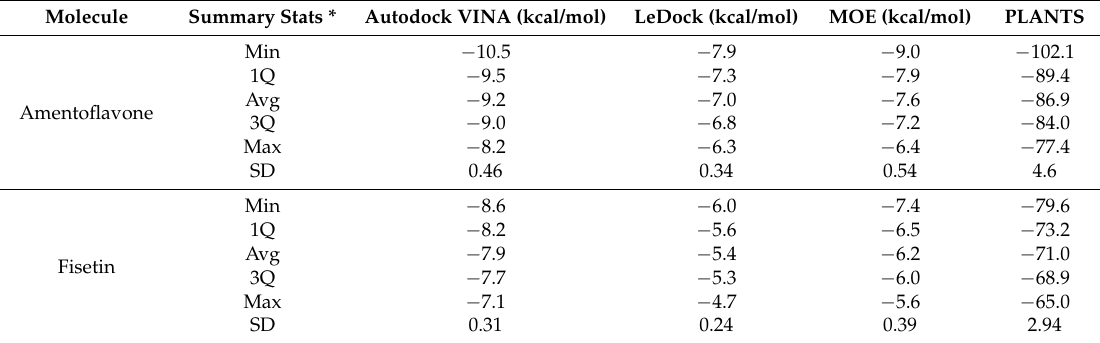
Table 1. Summary statistics of docking scores for the programs